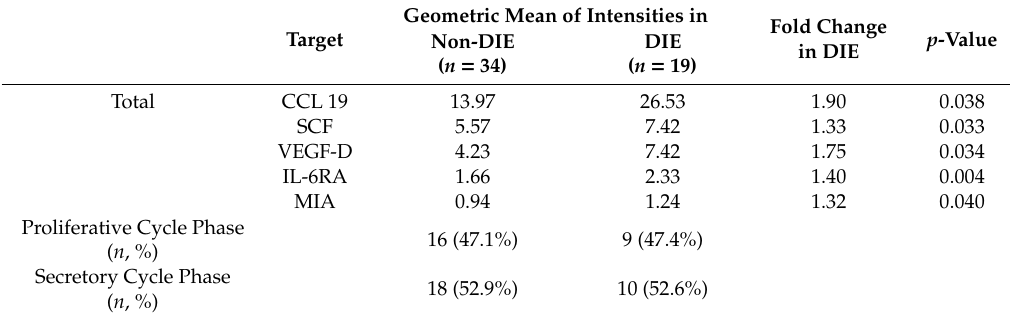
Table 3. Significant results in the comparison of target protein concentration between patients with DIE and endometriosis patients without DIE. The fold change describes the ratio of protein expression values between the two tested groups.